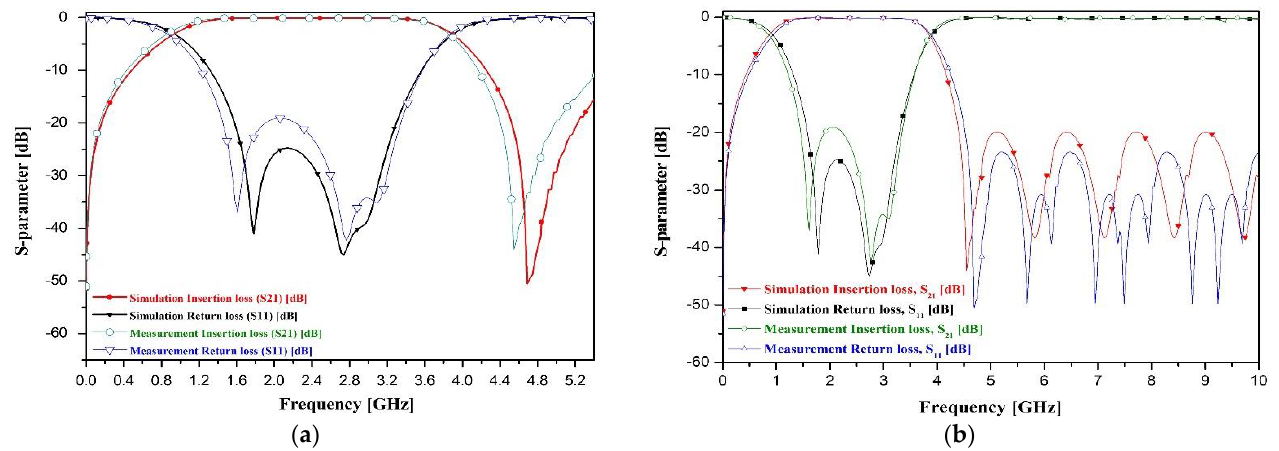
Figure 8. Experimental results for the proposed BPF: ( a ) narrow scale frequency band and ( b ) wide scale frequency band.